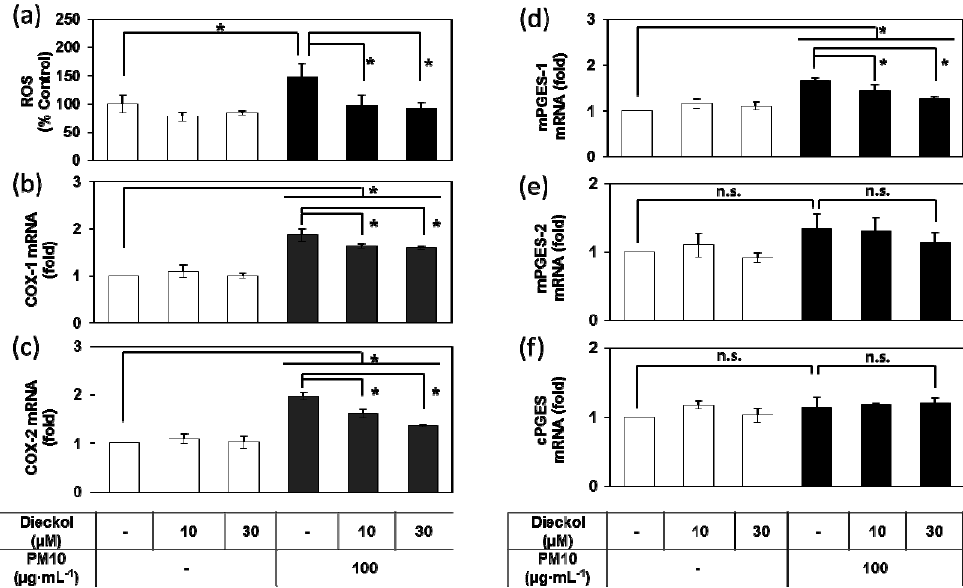
Figure 8. Effects of dieckol on the production of reactive oxygen species (ROS) and the gene expression of enzymes involved in PGE 2 synthesis in HaCaT keratinocytes exposed to PM10. Cells were treated with 100 μ g mL − 1 PM10 in the presence or absence of dieckol at the indicated concentrations for 30 min for the ROS assay ( a ), and for 24 h for the mRNA assays for COX-1 ( b ), COX-2 ( c ), mPGES-1 ( d ), mPGES-2 ( e ), and cPGES ( f ). Data are presented as a mean ± SD ( n = 4 for a and n = 3 for others). All treatments were compared to PM10 control using one-way ANOVA followed by Dunnett’s test. * p < 0.05; n.s. was not significant.